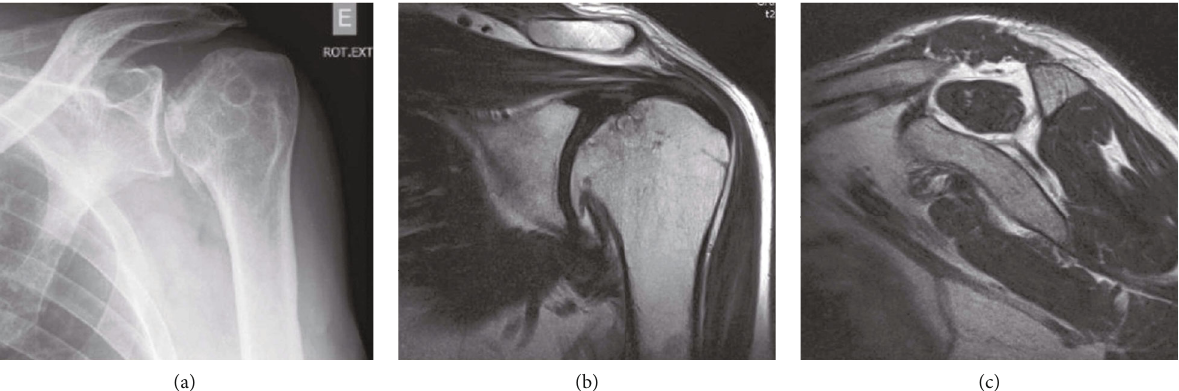
Figure 1: Anteroposterior plain radiograph of the left shoulder with the crescent sign, collapsed humeral head, and osteophyte (a); T2 coronal magnetic resonance image with a collapsed humeral head and large osteophyte (b); T1 magnetic resonance image with grade 1 rotator cu ff muscle fatty in fi ltration (c).